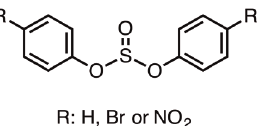
Figure 34 - Substrates used in the hydrolysis reaction by pepsin.